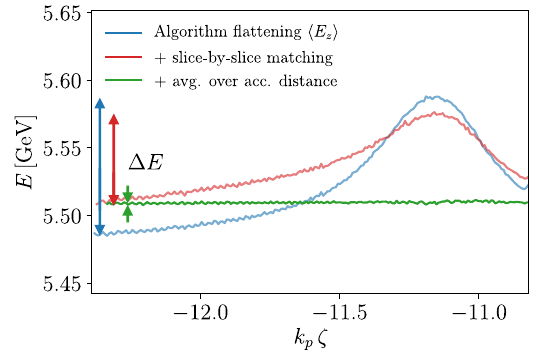
FIG. 4. Mean energy of each slice vs longitudinal position in the positron bunch after acceleration. The blue line refers to i with a longitudinal uniform σ algorithm flattening h E . The red z r line and the green line refer to additionally applying slice-by-slice matching and averaging of the bunch spot size over the accel- eration distance, respectively. That way, the correlated energy spread can be reduced to the noise